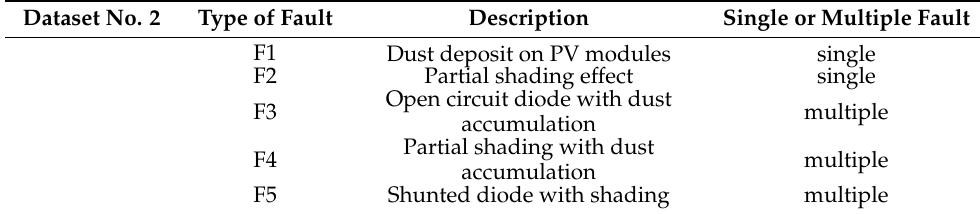
Table 1. Dataset